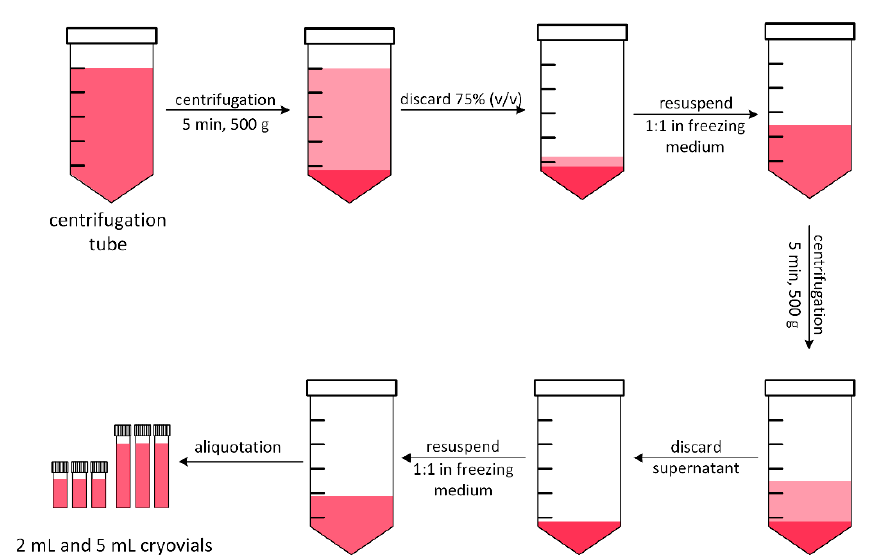
Figure 2. Scheme of the preparation of the cell suspension for freezing of the UHCD-WCB.